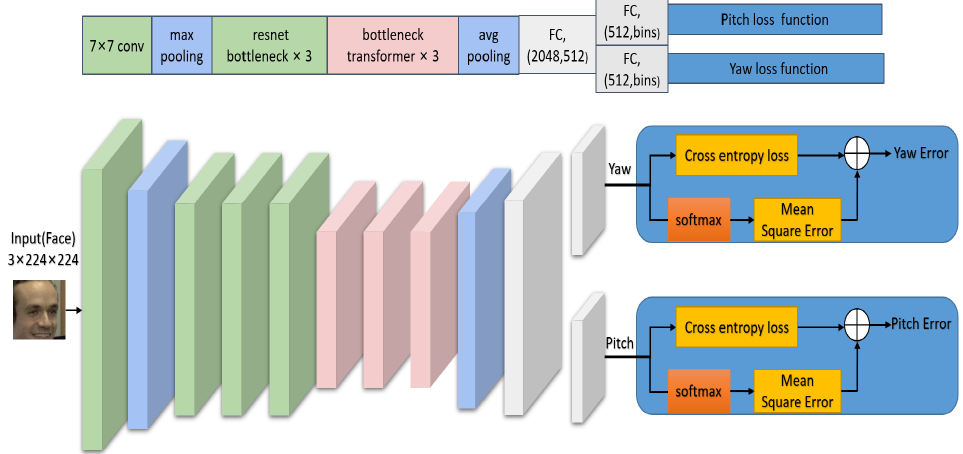
Figure 5. Bot2L-Net